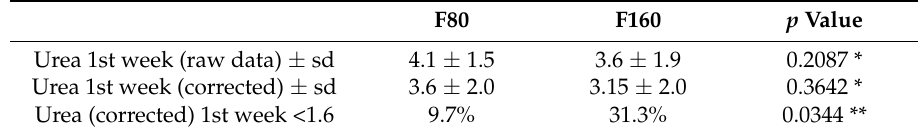
Table 4. Blood urea as a marker of protein intake adequacy.